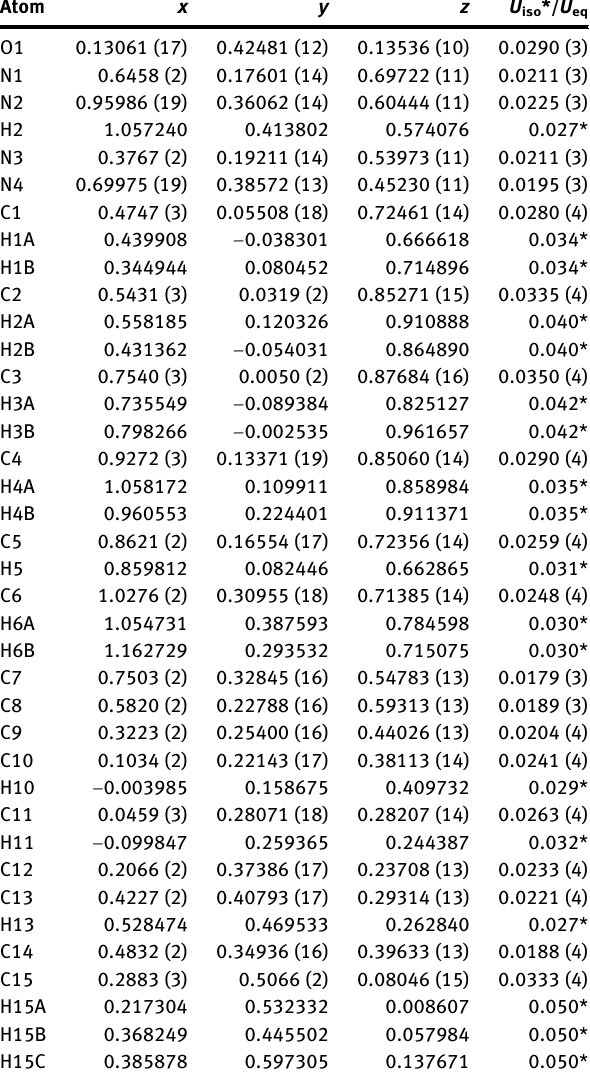
(see the Figure). All bond lengths and angles are in the expected ranges [12, 13].